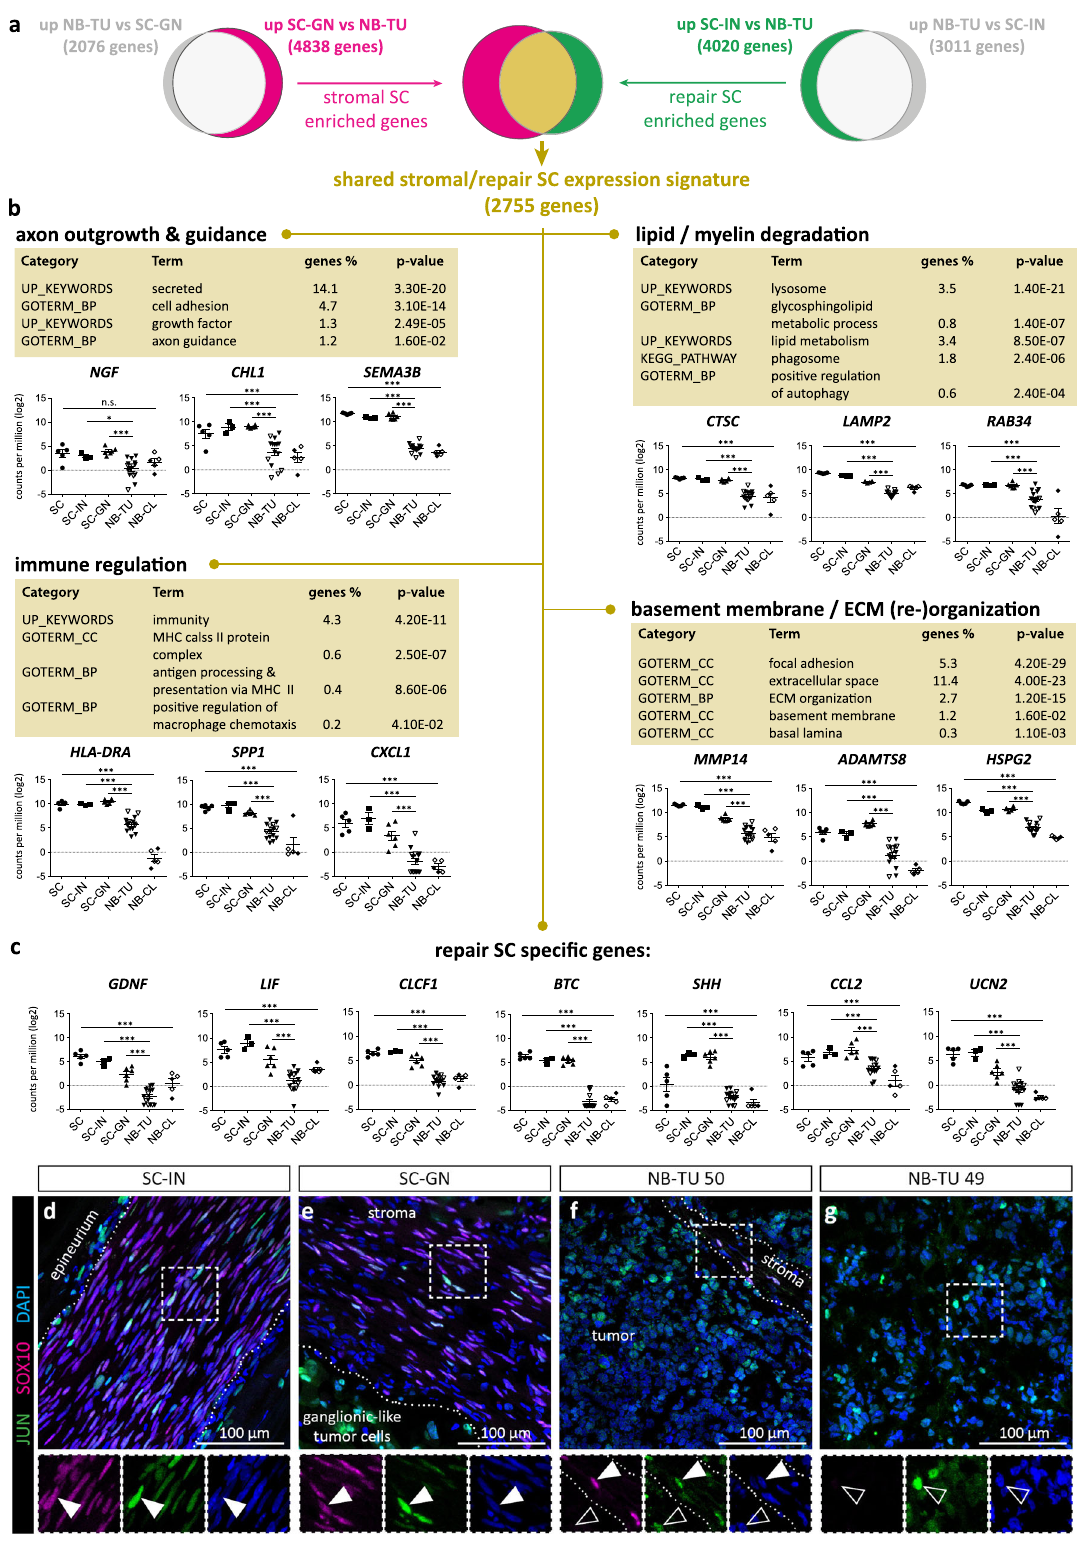
(Fig. 3e,f,g,h arrows). Quanti fi cation of neurite length and alignment con fi rmed a signi fi cant increase of the mean neurite length (Fig. 3i) and neurite alignment (Fig. 3j) in co-cultures. These results suggest that the contact to human repair-related SCs induces a directed neuritic out-growth of NB cells in